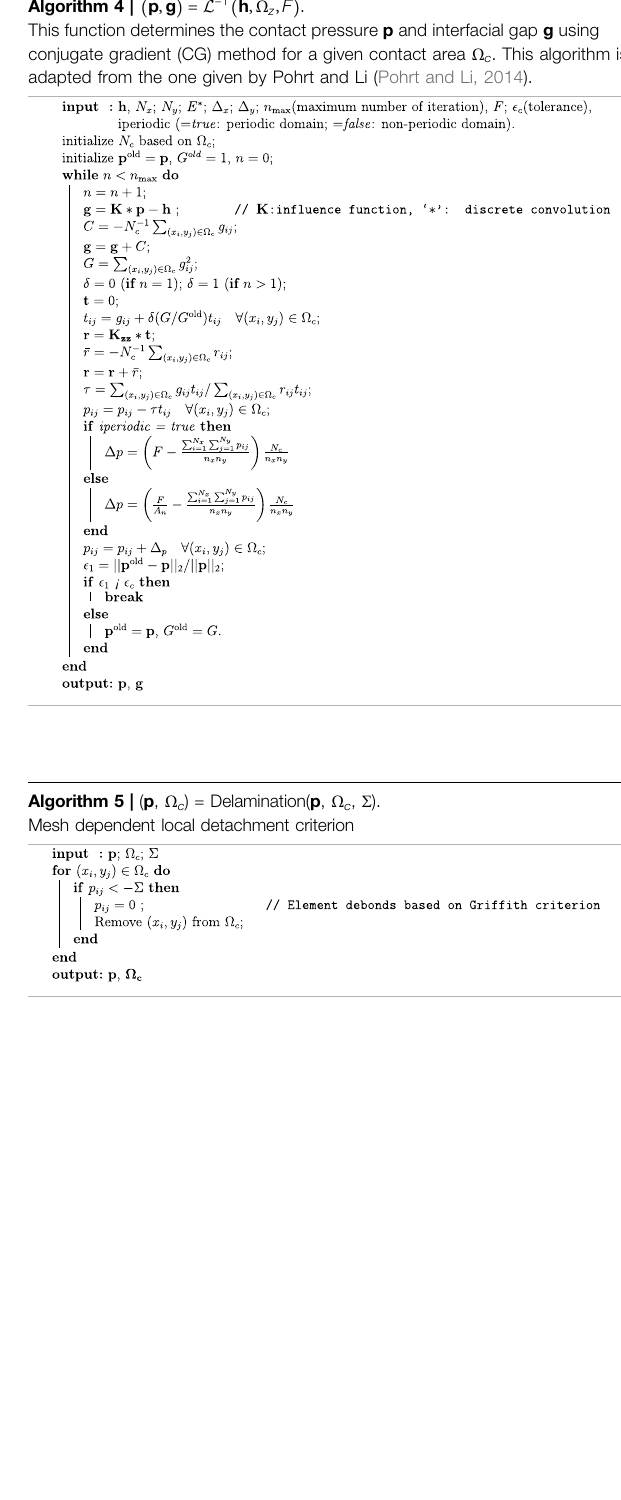
Algorithm 4 | (cid:20) p , g (cid:21) (cid:1) L − 1 (cid:20) h , Ω z , F (cid:21)